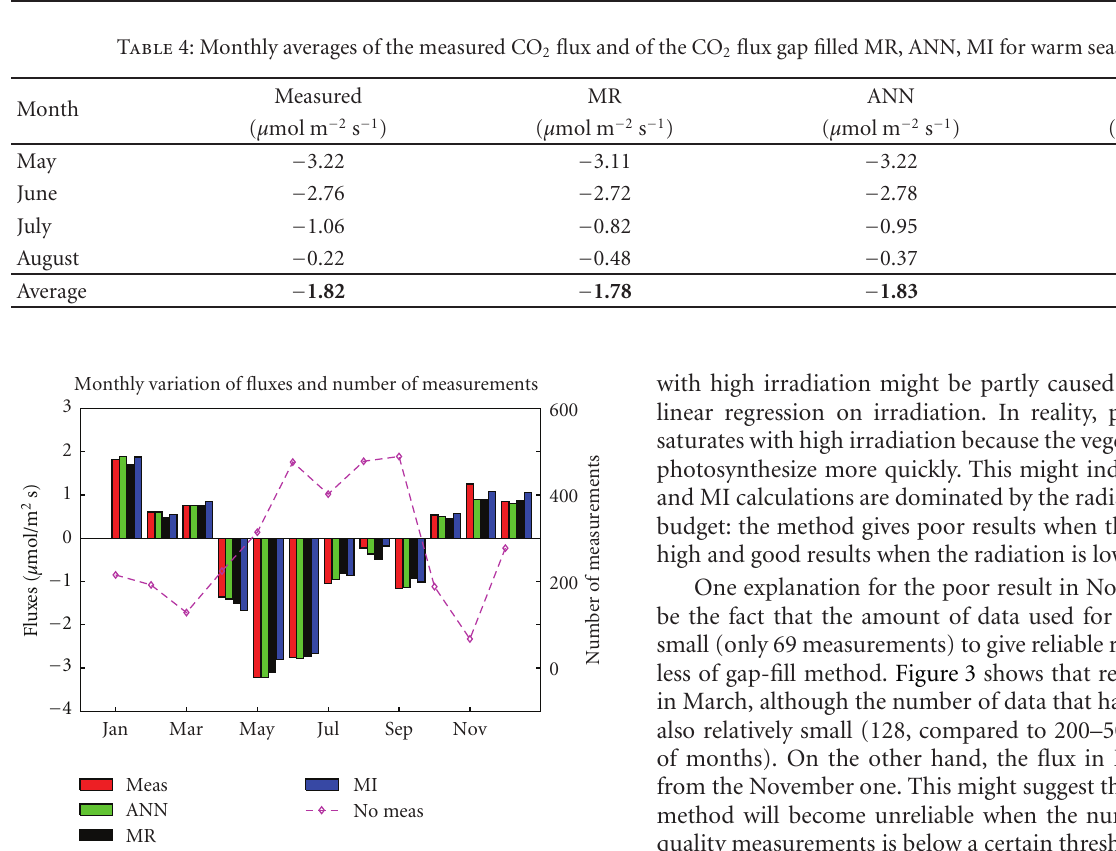
Figure 2: Monthly variations of the measured CO 2 flux (red) and of the CO 2 flux gap filled by multiple regression (MR: black), artificial neural network (ANN: green), and multiple imputation (MI: blue). Number of measurements is also shown as a pink dotted